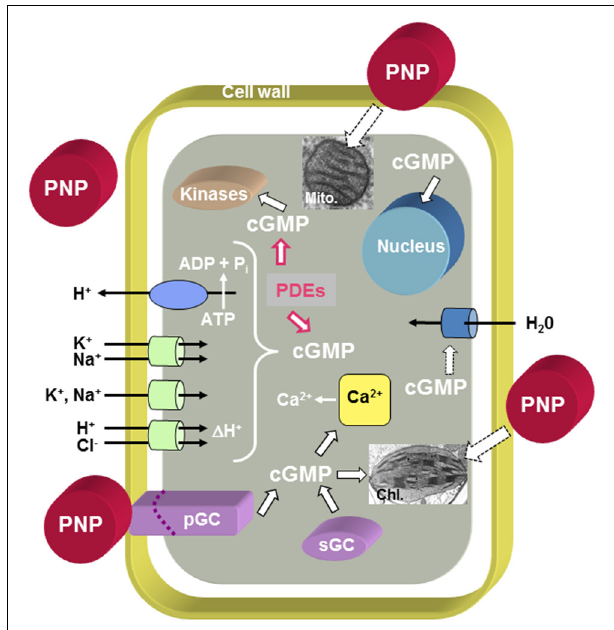
FIGURE 1 | Overview of PNP action at the cellular level. The model proposes that PNPs can dock to receptor-like molecules with ligand-inducible guanylate cyclase activity (pGCs) and that cGMP acts as second messenger while phosphodiesterases (PDEs) metabolize cGMP to GMP. Cyclic GMP can affect cytosolic Ca 2 + levels by modulating ion channels [e.g., Cyclic Nucleotide Gated Channels (CNGCs)], activate phosphorylation through kinases and in turn affect the transcriptome and (phospho-)proteome. It is also conceivable that PNP acts directly or indirectly via PNP-dependent phosphorylation on aquaporins. There is also evidence for PNP-dependent modulation of chloroplast and mitochondrial function. Solid black outlined arrows indicate established functions, red outlined arrows indicate inhibitory effects, and dashed outlined arrows indicate that the effects require further